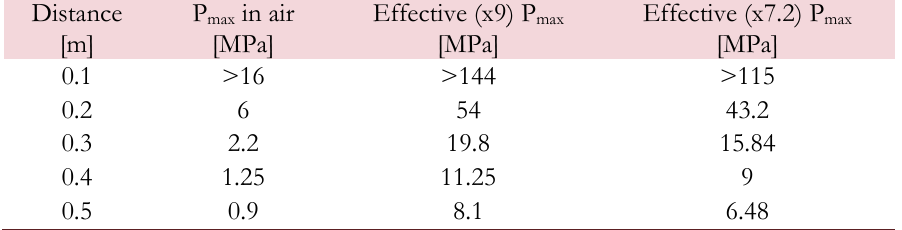
essure waves come stronge